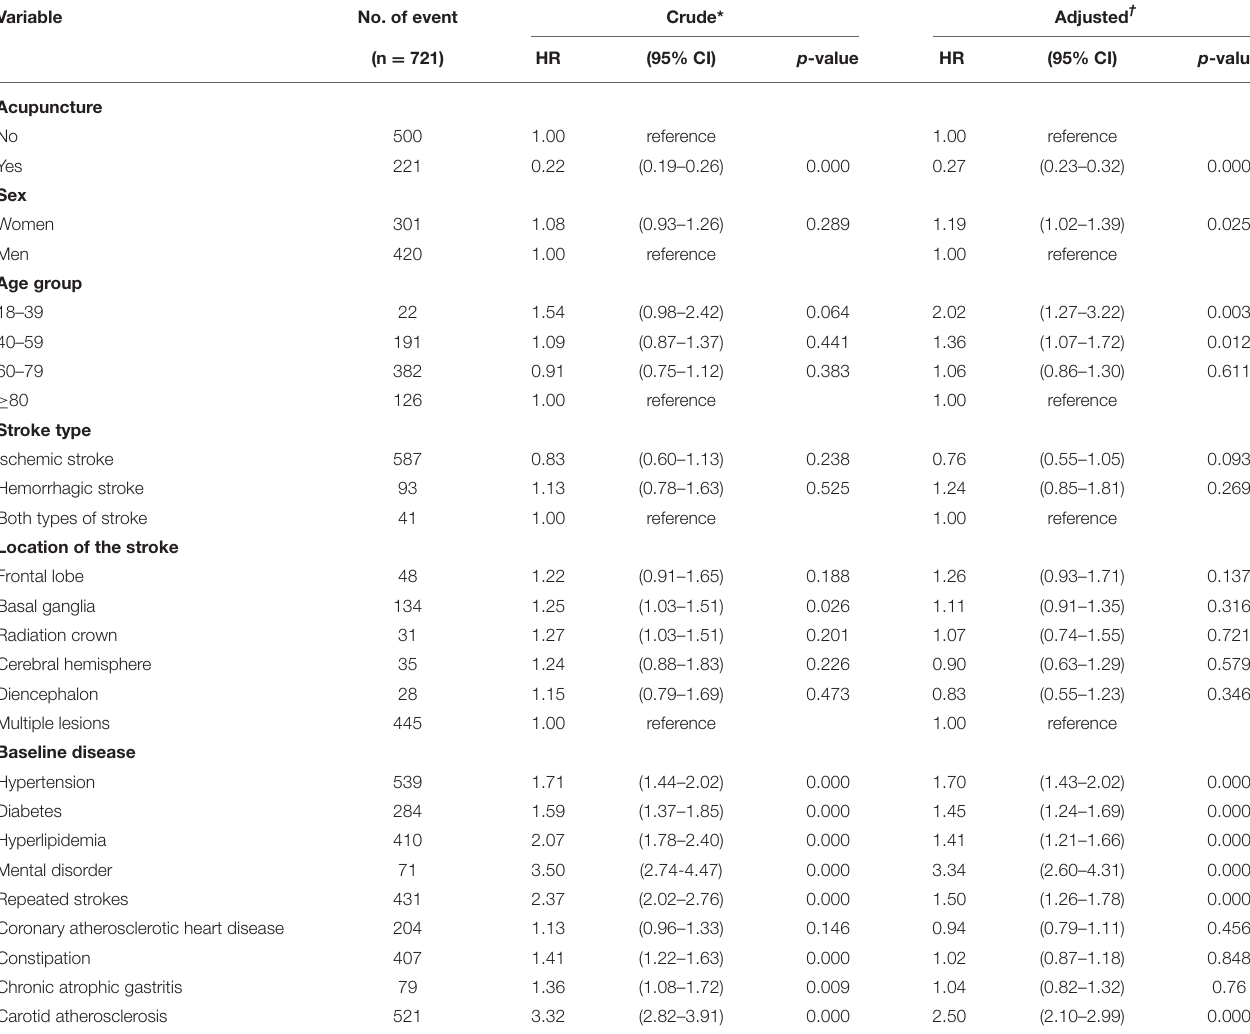
TABLE 2 | Cox model with hazard ratios and 95% confidence intervals of each covariate that developed into insomnia after stroke.